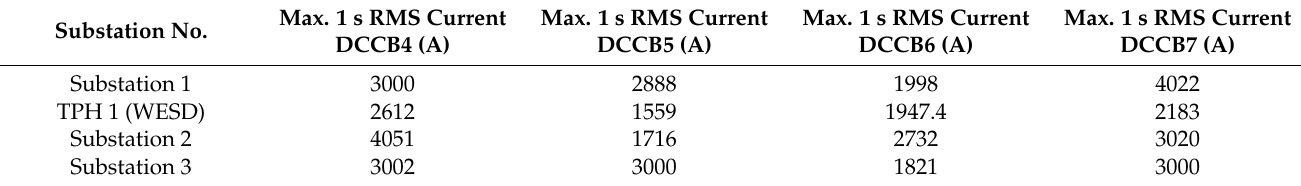
Table 12. Traction power modeling simulation results.